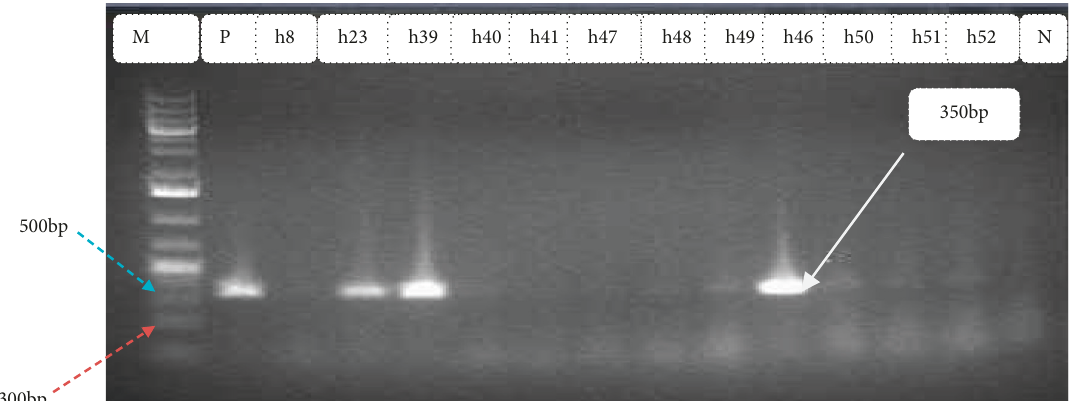
Figure 3: Amplification of stx1 gene in Escherichia coli isolates from diarrheic children: M Marker (100bp DNA ladder) P positive control, Lane No. h23, h39, and h49 indicate positive samples, Lane No. h8, h40, h41, h47, h48, h49, h51, and h52 indicates negative samples and N negative